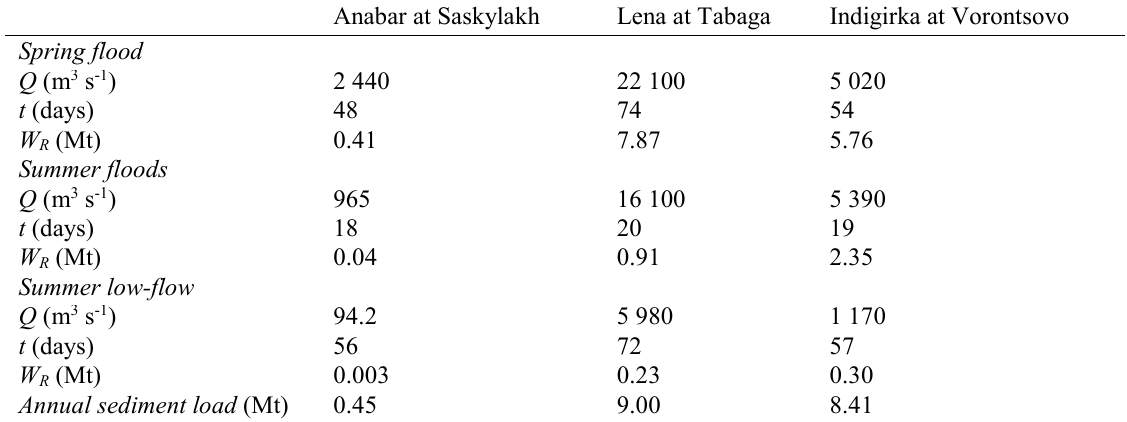
Table 5 Long-term seasonal and annual suspended sediment loads of the Russian Arctic study rivers. Anabar at Saskylakh Lena at Tabaga Indigirka at